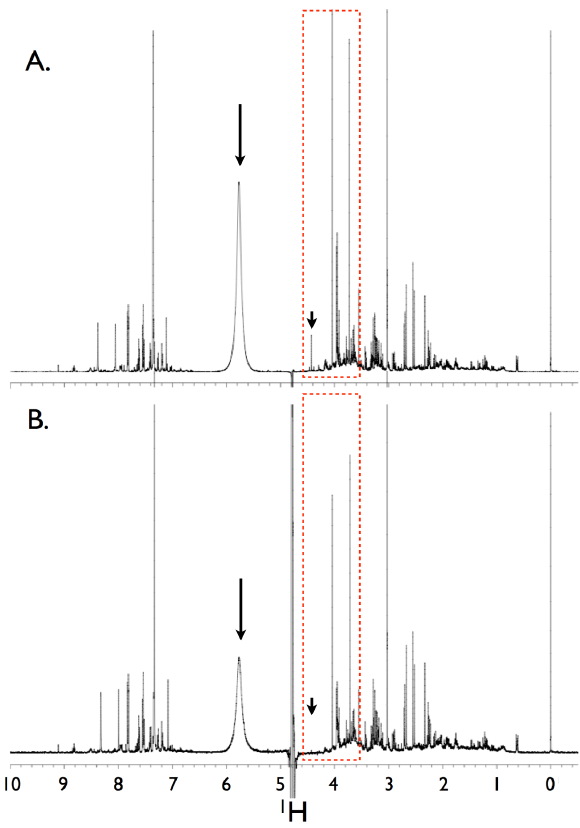
Figure 4. Effects of solvent suppression using two different probes on the same sample. The spectra were acquired utilizing the identical NMR pulse sequence as in Figure 1, with the exception that ( A ) was acquired using a 5 mm probe on a 600 MHz spectrometer at the University of Alberta and ( B ) was acquired using a 3 mm HX probe with Z-axis pulsed field gradients on a 500 MHz spectrometer at the University of Michigan. The decibel value of both settings for excitation and saturation were maintained between probes. However, due to probe design differences, the resulting pulse width for the 3 mm probe was 120 u (same instrument decibel setting), and the saturation power for this probe resulted in a c B1-induced field of 226 Hz or 8 dB. The difference in metabolite intensities ( e.g. , urea at , 5.8 PPM, and sharp peaks at , 4.0 and , 3.75 PPM) in the same urine sample is readily evident. This inspired our extensive investigation to identify which experimental parameters were responsible for these differences, and to determine how the sensitivity of the metabolite resultants changed in response to several common NMR parameters (see text for details). The large arrows designate urea peaks, the small arrows indicate trigonelline (which was not observed in the 3 mm probe spectrum), and the red dashed-line boxes represent a region of the spectra that exhibited marked peak suppression, particularly around 4.5 PPM, near the water region.